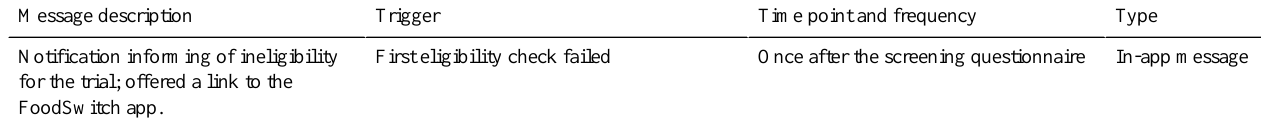
Table 2. Key notification and reminder messages delivered by the Food Label Trial app